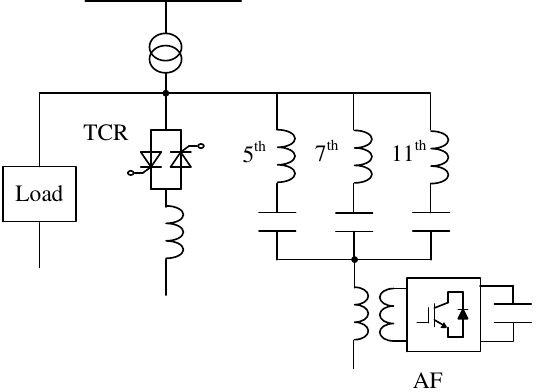
Figure 1. Power circuit diagram of the previously proposed hybrid static VAR compensator (SVC) with a series active filter (AF)